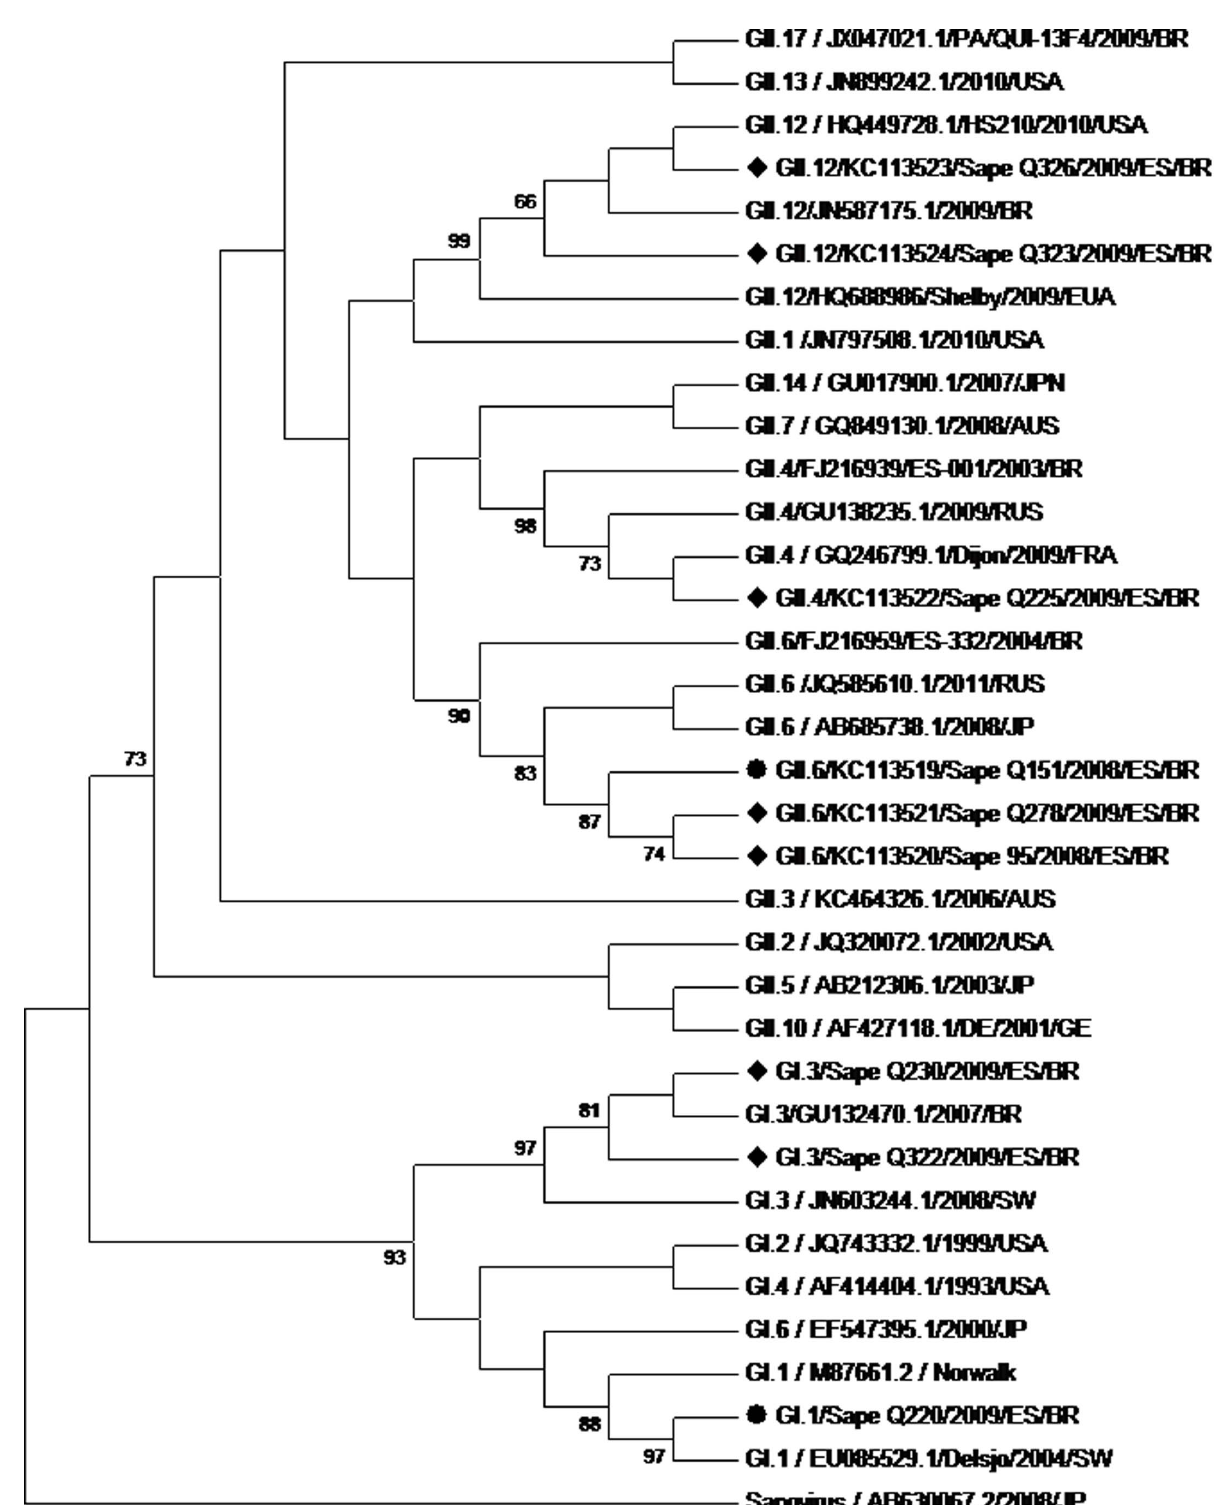
Figure 2. Phylogenetic tree of D region. Phylogenetic tree constructed by the Neighbor-joining method based on the partial nucleotide sequence of the Norovirus VP1 protein gene D region. Highlighted strains identified by ‘‘Sapeˆ’’, originated in fecal samples from ‘‘Quilombola’’ children and were analyzed along with prototype norovirus genotypes of GI and GII taken from the ‘‘GenBank.’’ All strains were identified by N genotype/accession number/year/origin. Sapovirus/AB630067.2/2008/JP was added as a reference group. Values of ‘‘Bootstrap (2,000 replicates) are Samples Q51 and Q220 belong to another study site near the Quilombola communities. ¤ Samples of this shown at the junction of the branches. study.